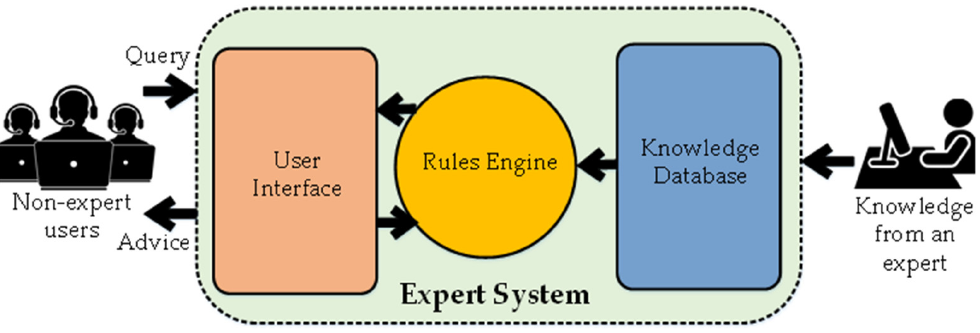
Figure 2. Generic operation of an Expert System.